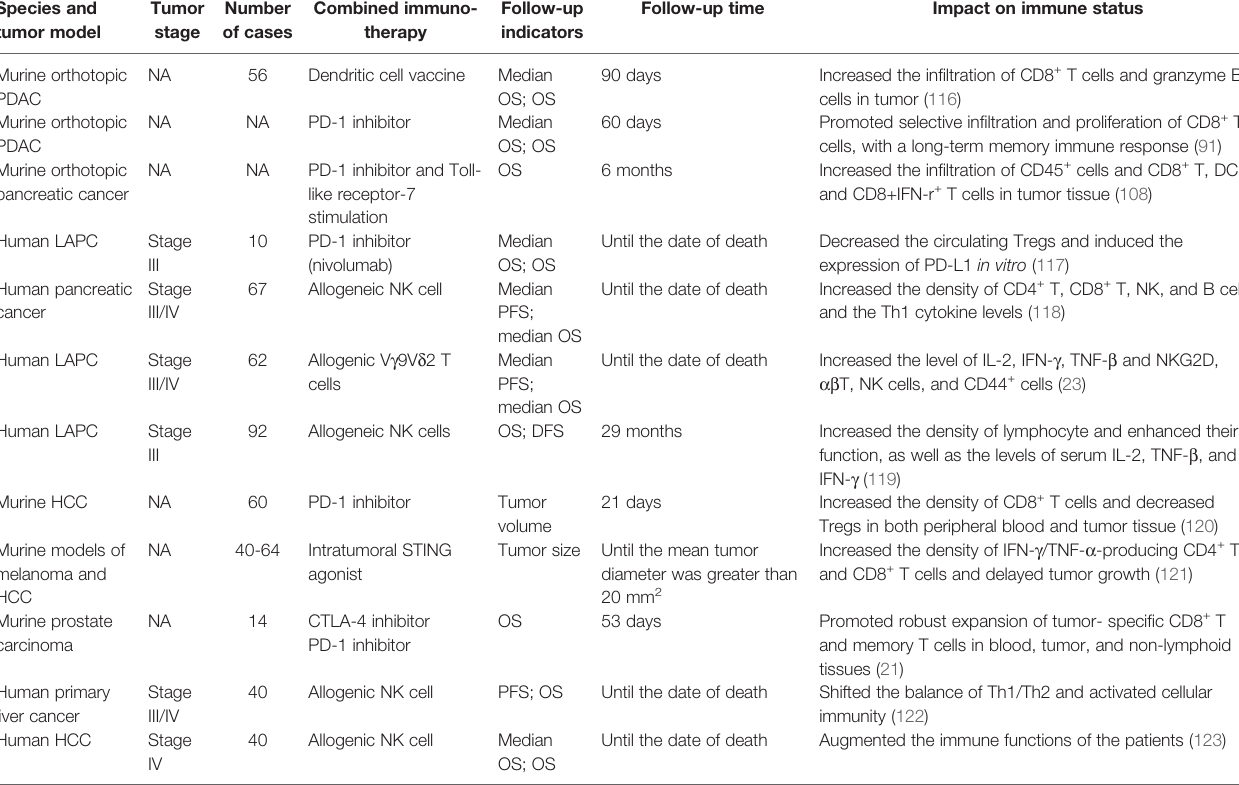
TABLE 2 | The information of the effect of IRE combined with different immunotherapies on the survival and immune status of tumor-bearing body. Species and Tumor Number Combined immuno- tumor model stage of cases